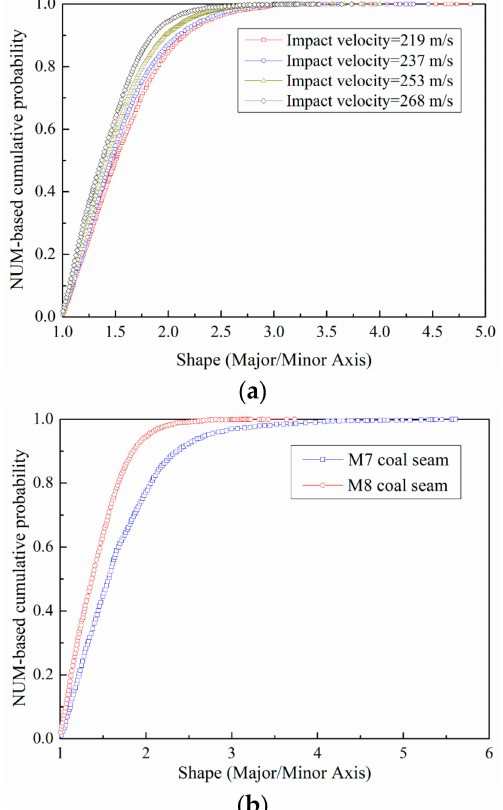
Figure 10. NUM-based cumulative probability for the shape of coal fragments. ( a ) Shape distributions of coal fragments under different jet impact velocities in the M8 coal seam. ( b ) Shape distributions of the various coal seams under the same jet velocity of 268